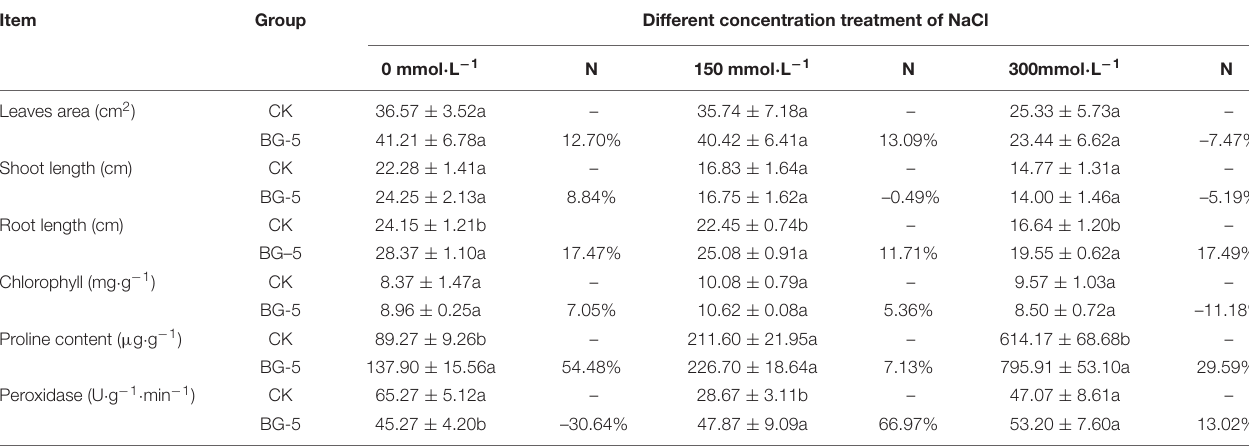
TABLE 6 | The effects of BG-5 strain on cotton growth under 0, 150, and 300 mmol · L − 1 NaCl